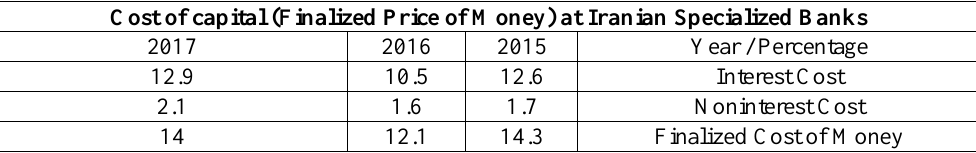
Table 2. Overview of Finalized Price of Money at Iranian Specialized Banks from 2015 to 2017 Cost of capital (Finalized Price of Money) at Iranian Specialized